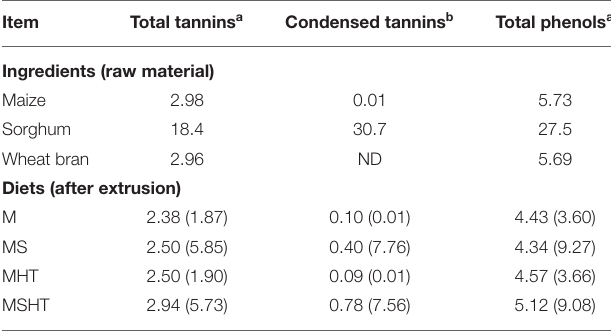
TABLE 3 | Phenolic compounds present in ingredients and experimental